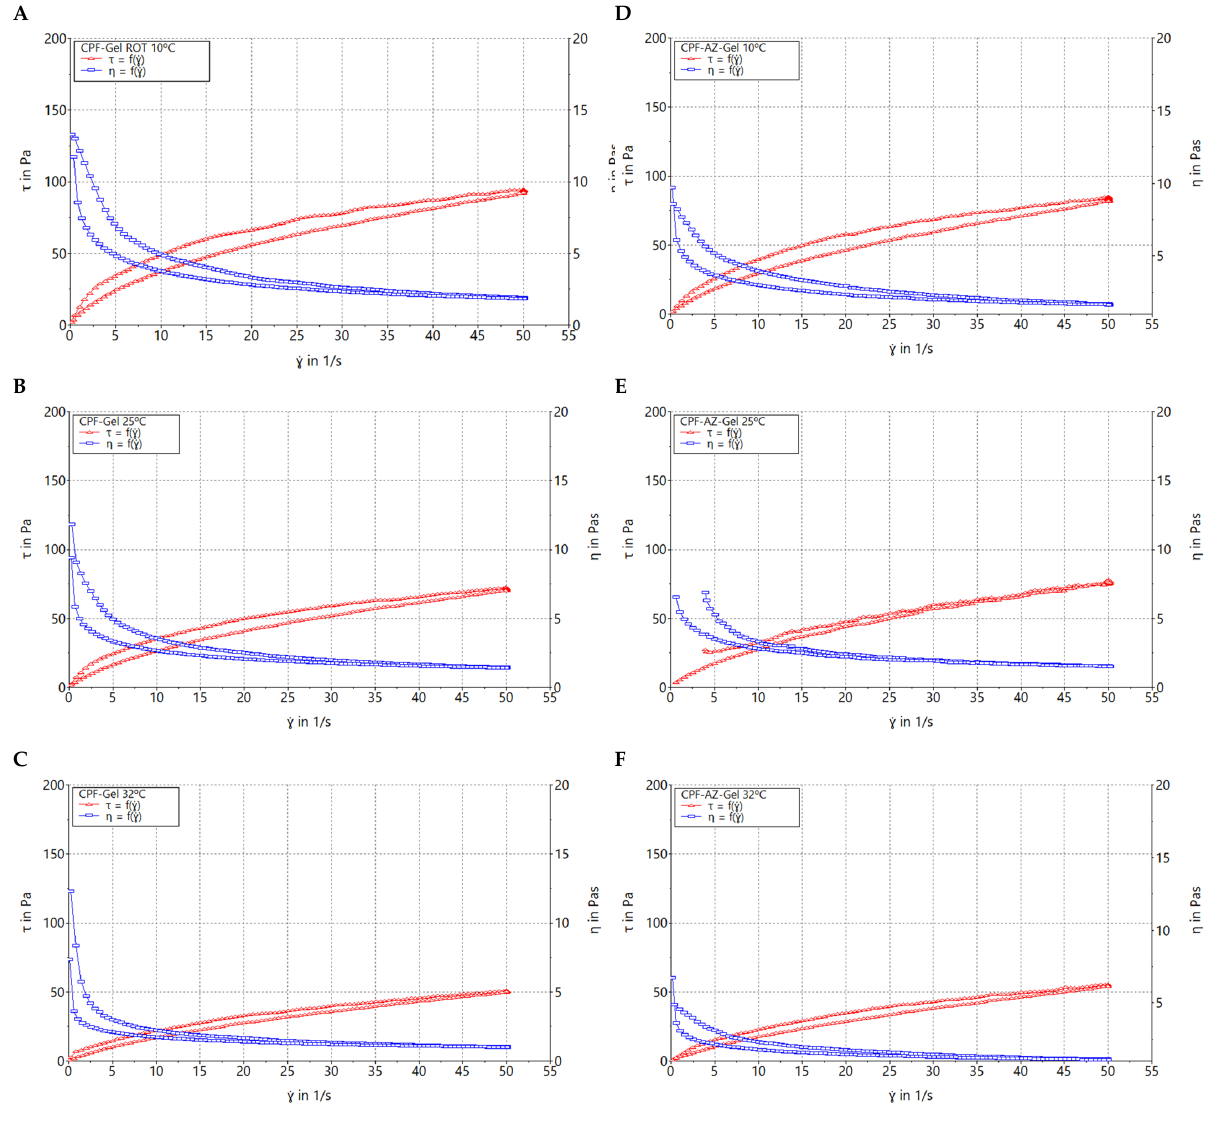
Figure 8. Rheograms of caspofungin formulations. ( A ) CPF-gel at 10 °C, ( B ) CPF-gel at 25 °C, ( C ) CPF-gel at 32 °C, ( D ) CPF-AZ-gel at 10 °C, ( E ) CPF-AZ-gel at 25 °C, and ( F ) CPF-AZ-gel at 32 °C.